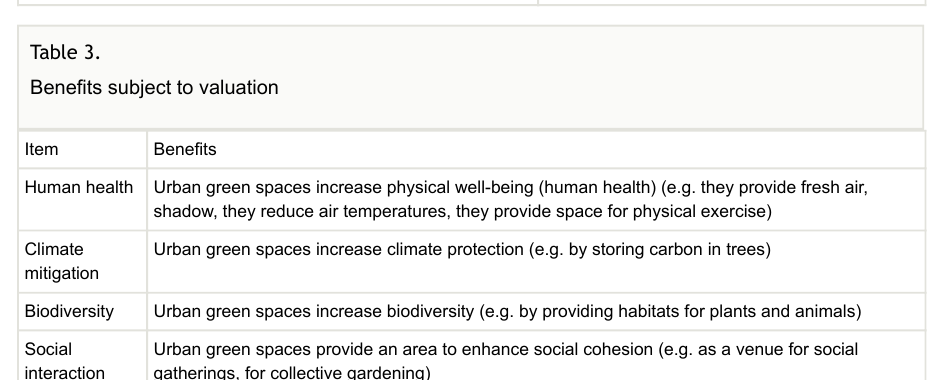
Benefits subject to